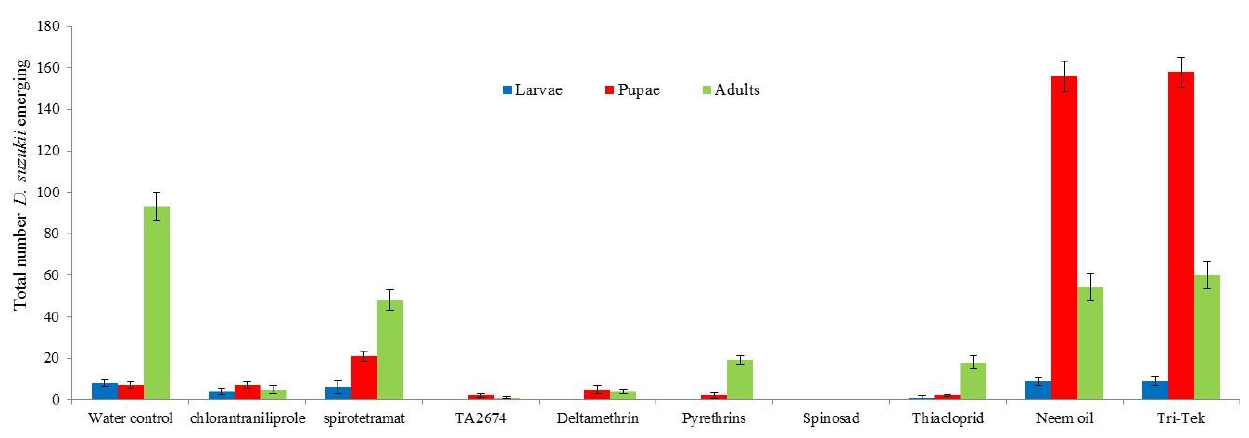
Figure 4. Impact of treatments on emergence of Drosophila suzukii from infested blueberries (assessed after 10 days incubation at 25 °C). Total numbers from 40 berries per